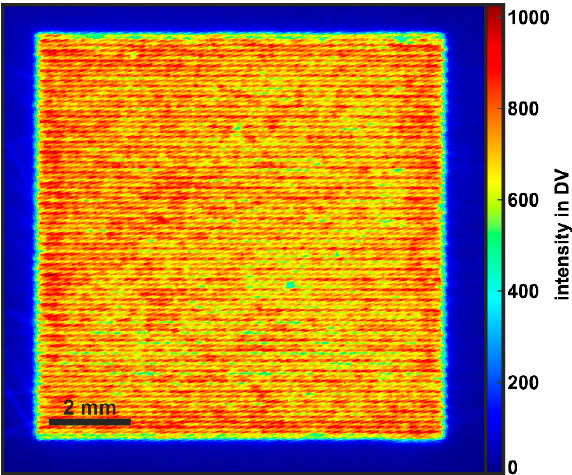
Figure 7. Typical optical tomography (OT) image of the base volume A (layer 99), built with standard parameters. The intensity distribution is quite homogeneous, and the hatching pattern can be observed.